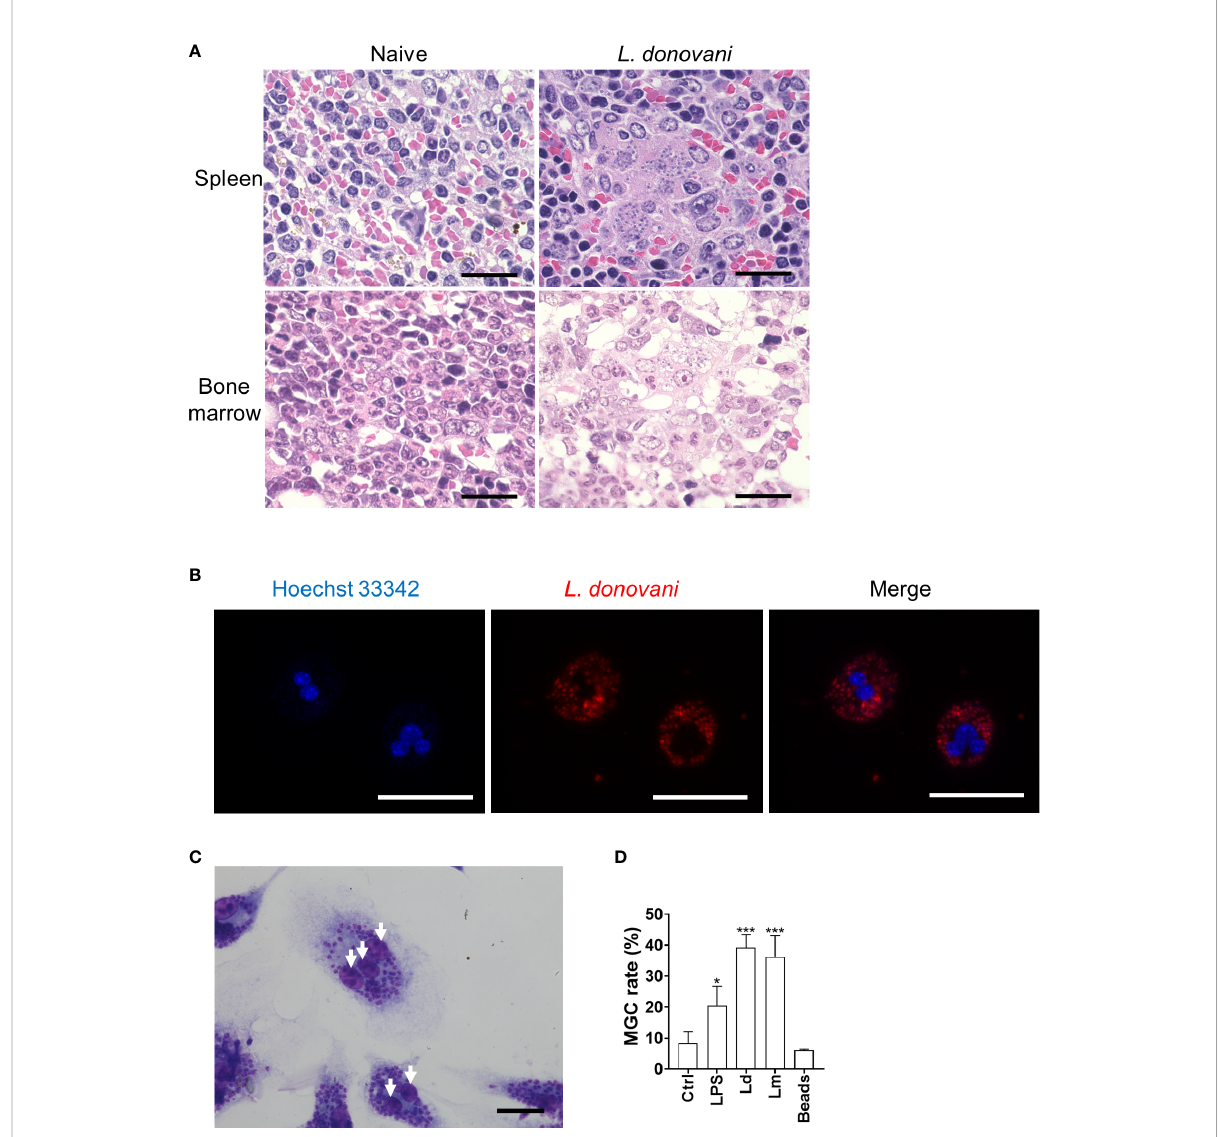
FIGURE 1 Leishmania infection promotes macrophage multinucleation. (A) Micrographs of H&E-stained sections of the spleen and bone marrow from naive or Leishmania donovani -infected BALB/cA mice at 24 weeks post-infection are shown. Bars, 20 m m. (B) Multinucleated giant cells (MGCs) with CytoRed-labeled L. donovani amastigotes. Nuclei were stained with Hoechst 33342. Bars, 50 m m. (C) Giemsa-stained bone marrow- derived macrophages (BMDMs) infected with L. donovani . Bar, 20 m m. White arrows, nuclei. (D) BMDMs were either untreated, stimulated with LPS, infected with L. donovani or L. major , or cultivated with latex beads for 72 h. Cells with two or more nuclei were counted as MGCs. MGC rates were calculated by analyzing over 100 cells in each experiment, and the mean + SD of three independent experiments is shown. * P < 0.05, *** P < 0.001 vs. the control group by one-way ANOVA followed by Dunnett ’ s multiple comparisons